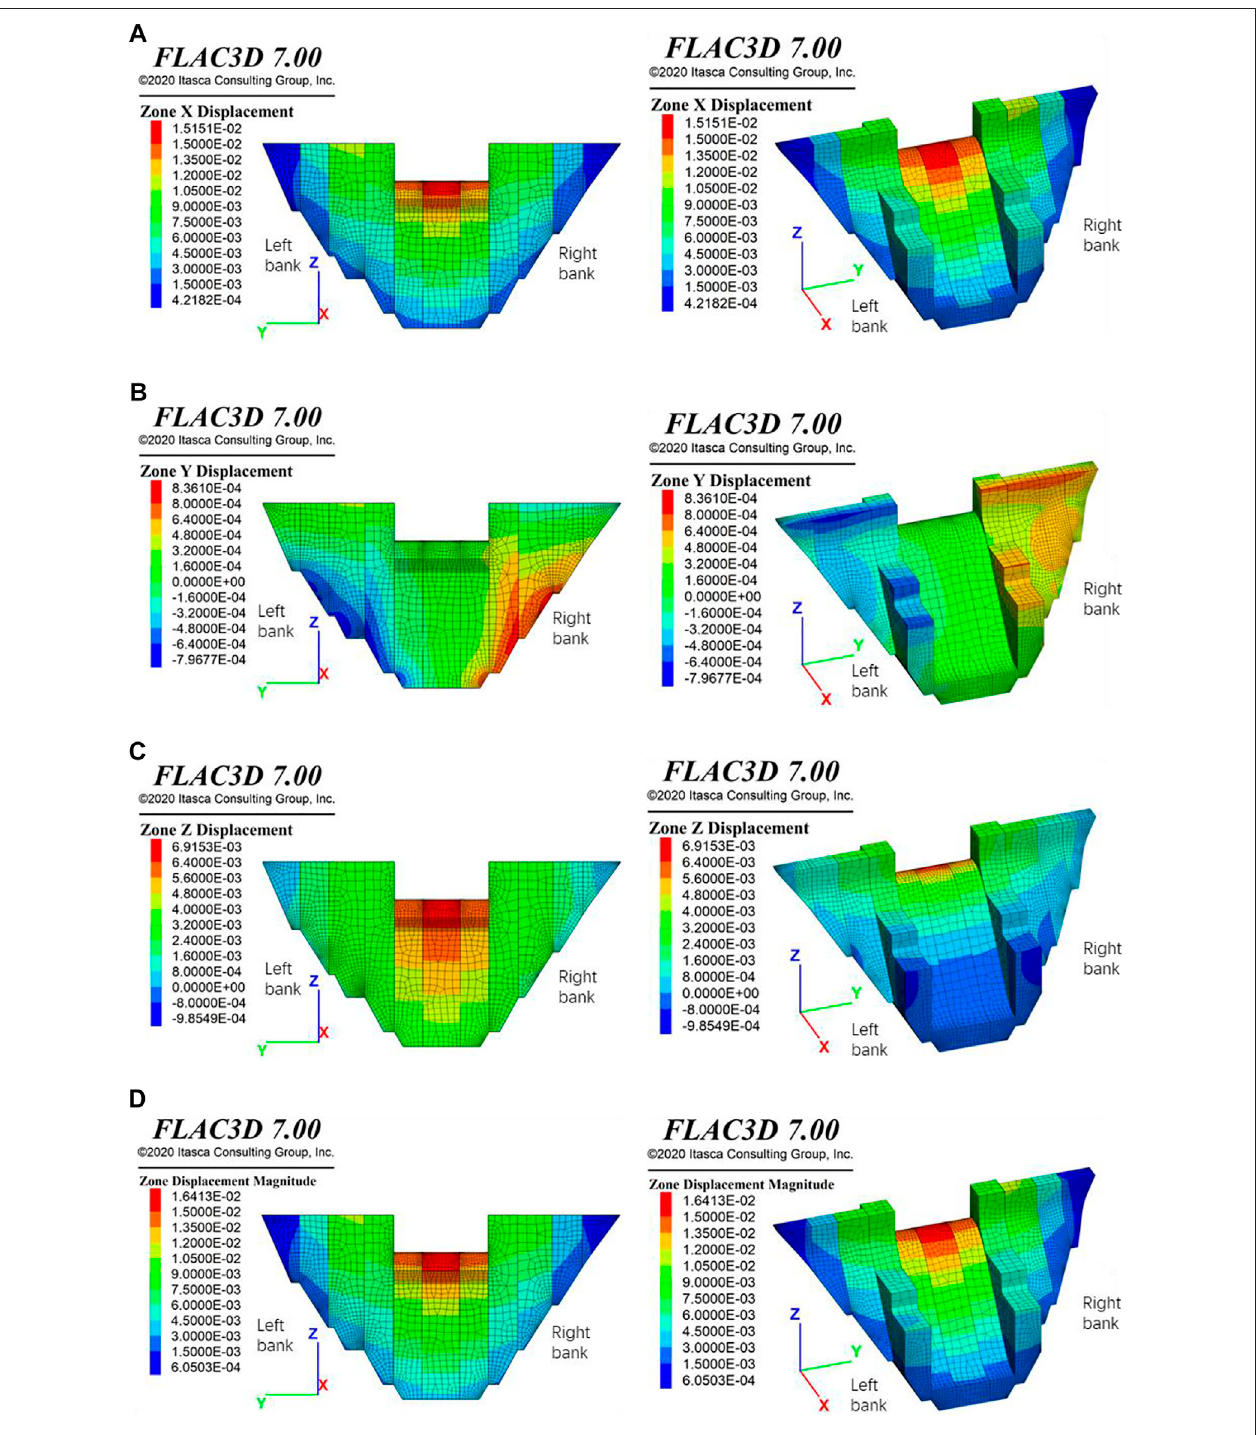
FIGURE 6 | Modeling results of displacement (A) Displacement along the river. (B) Transverse displacement across the river. (C) Vertical displacement. (D) Resultant displacement (left sub fi gures: upstream view, right sub fi gures: downstream view).